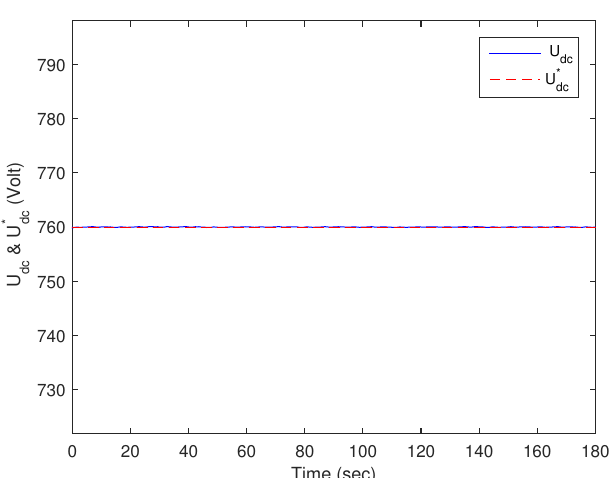
Figure 15. The voltages U dc and U ∗